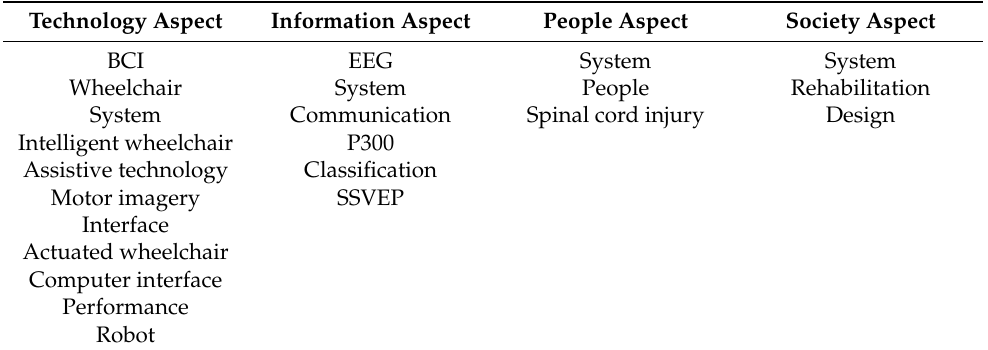
Table 9. Keywords of EPW HMI methodology research in the